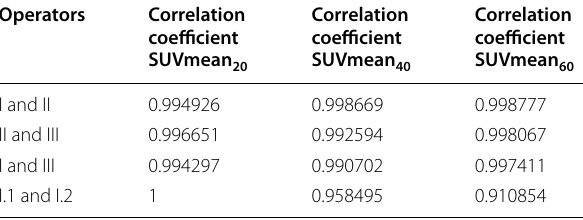
Table 4 Inter‑ and intra‑operator